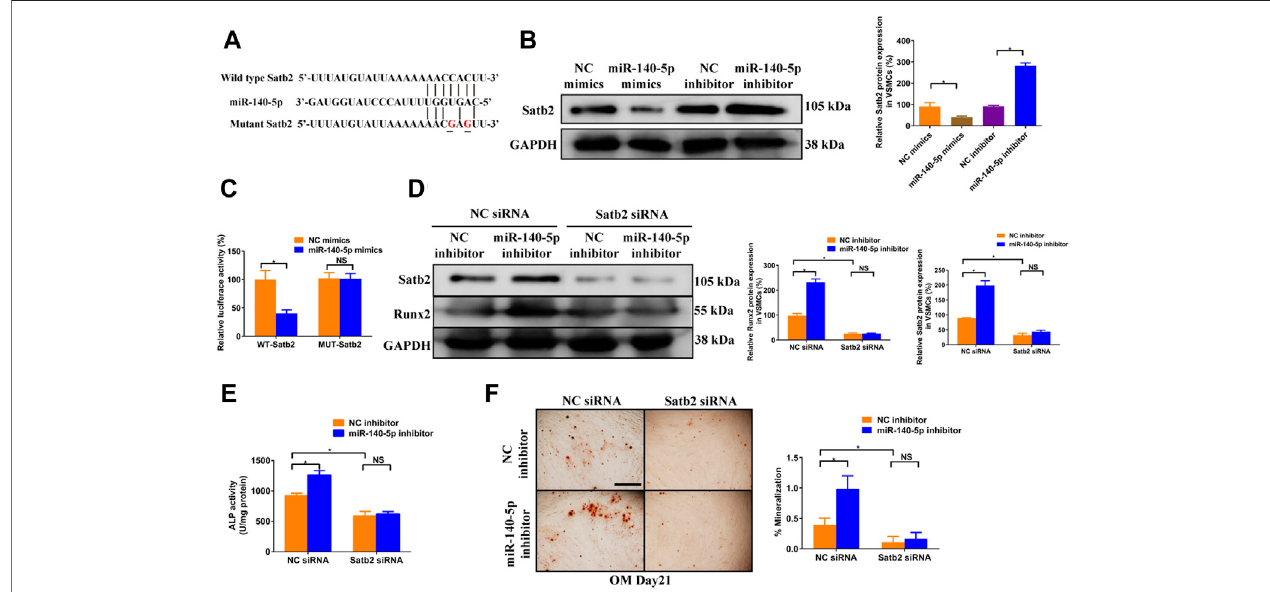
FIGURE 4 | miR-140-5p antagonises osteogenic differentiation of VSMCs by targeting Satb2. (A) Schematic view of miR-140-5p putative binding sites in WT and MUT Satb2 3 ′ -UTR. (B) Western blotting was performed to determine the protein expression of Satb2 in VSMCs transfected with speci fi c miR-140-5p mimics or inhibitor. The data were presented as densitometric ratios normalized to GAPDH [ (B) , lower panel]. (C) VSMCs were transfected with luciferase report vector containing WT or MUT Satb2 3 ′ -UTR following by transfection of miR-140-5p mimics or control mimics. Luciferase activity was determined 48 h post transfection and luciferase activity was normalised to Renilla luciferase activity. (D) Western blotting was performed to determine the protein expression of Satb2 and Runx2 in VSMCs transfectedwithspeci fi cmiR-140-5pinhibitorwithorwithoutSatb2siRNA.ThedatawerepresentedasdensitometricratiosnormalizedtoGAPDH[ (D) ,lowerpanel]. (E) The ALP activity was determined by an Elisa kit in VSMCs infected with inhibitor of miR-140-5p in the presence of Satb2 siRNA or not. (F) Alizarin Red S staining were measured in ß -GP-treated VSMCs infected with inhibitor of miR-140-5p in the presence of Satb2 siRNA or not for 21 days. Representative microscopic views are shown. Scale bar represents 200 µm. Data were presented as ratio of positive staining area [ (F) , right panel]. Each experiment was repeated for three times. The data represent the mean ± SD of triplicates. * p < 0.05.